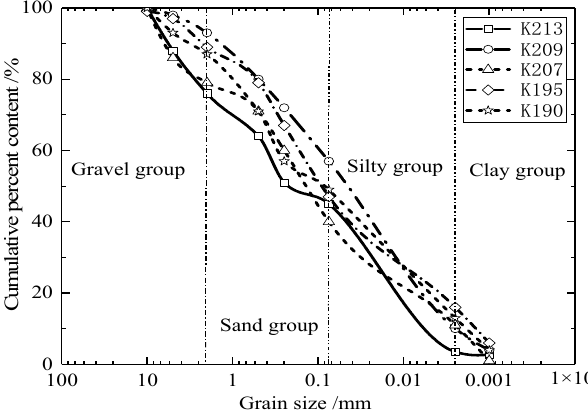
Figure 2. Grain-size distribution of the C-M-S samples.